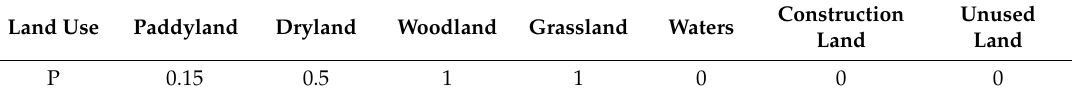
Table 2. P-factor values assigned for di ff erent land use types on the Guizhou